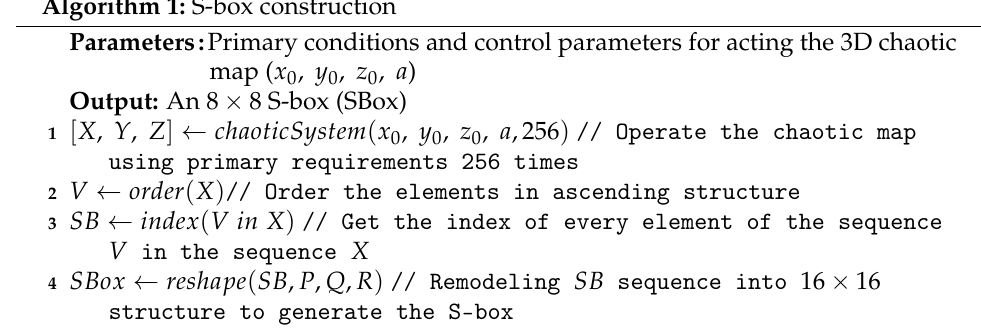
Algorithm 1: S-box